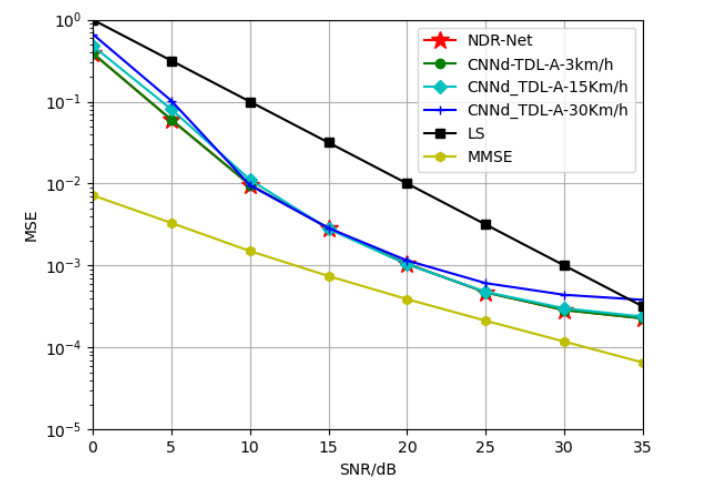
Figure 6. Generalization performance of TDL-A channels at different training velocities when testing velocity = 30 Km/h.